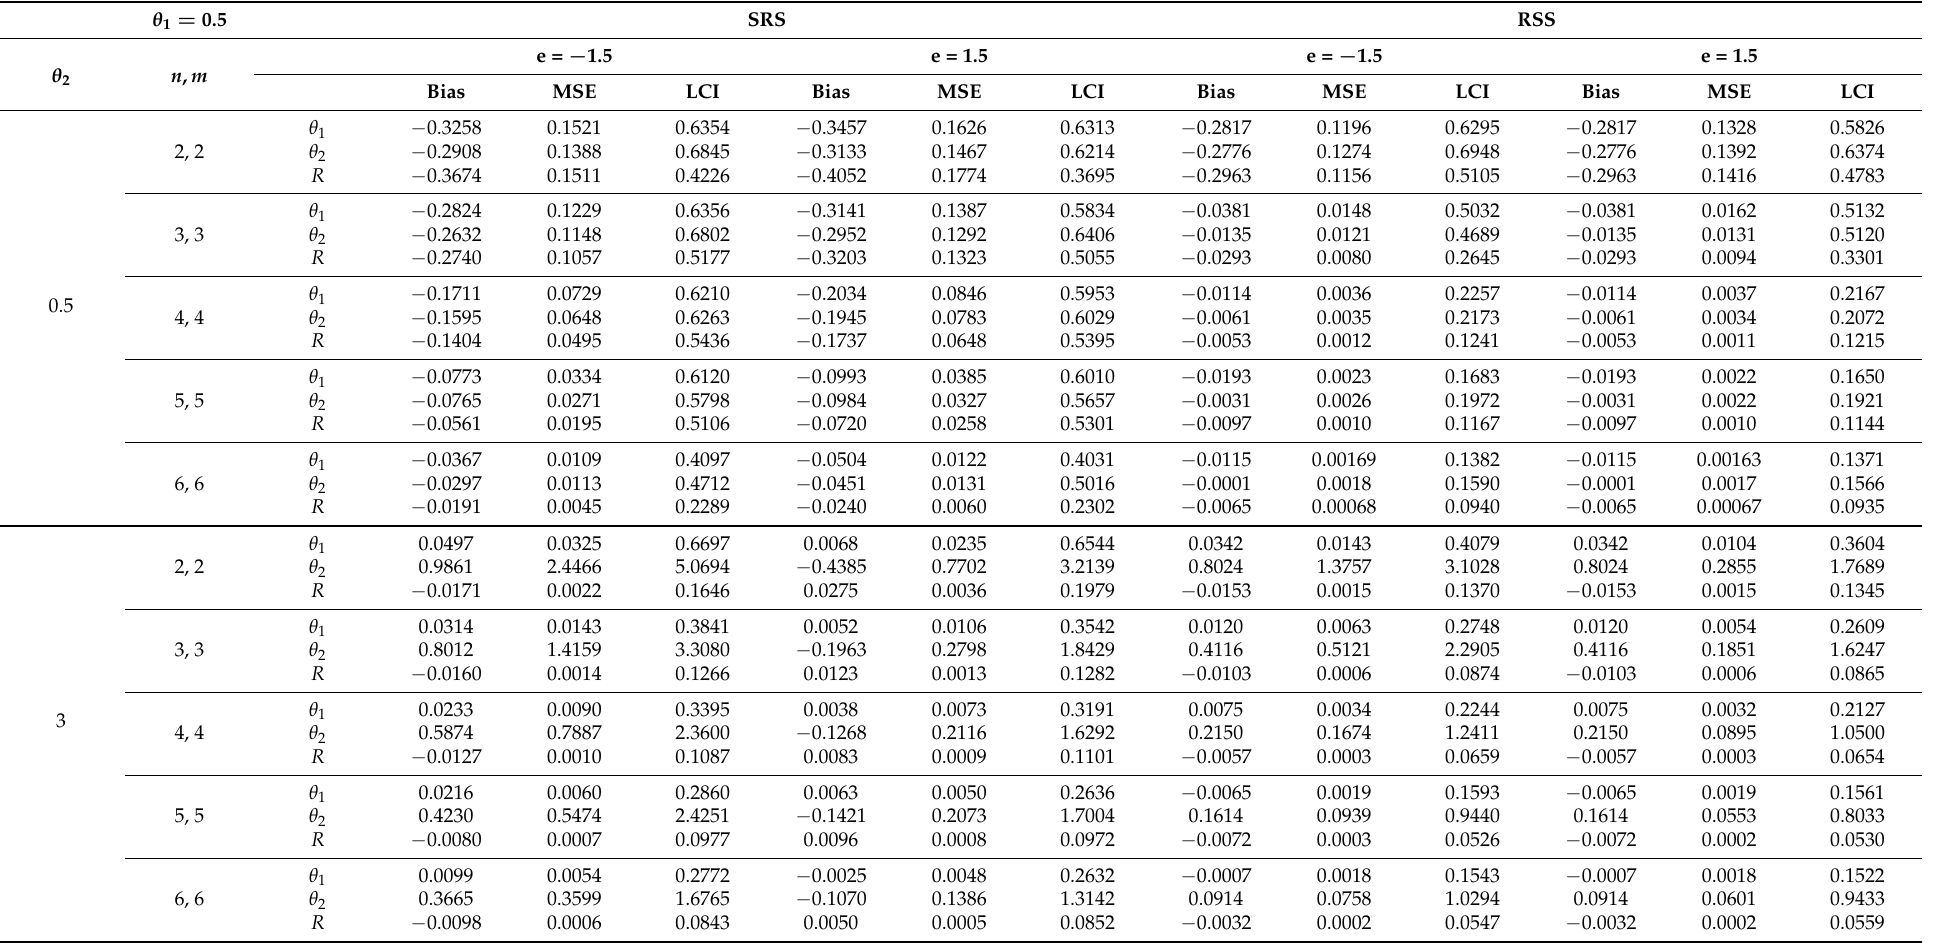
Table 6. SRS and RSS by Bayesian Method with NIP under LINEX Loss Function of Parameters and R of ITL Stress Strength Model θ 1 =